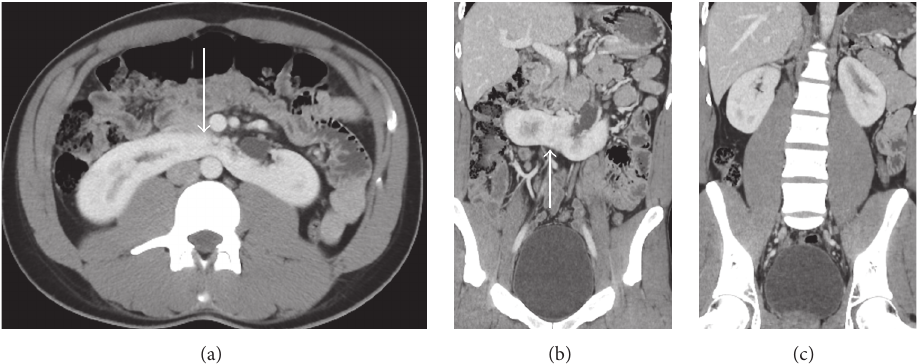
Figure 1: 27-year-old male with horseshoe kidney. Axial (a) and coronal (b) contrast-enhanced CT images show the inferior aspect of a horseshoe kidney in the lower abdomen. Note the enhancing isthmus of renal parenchyma crossing the midline (arrow). A coronal contrast- enhanced CT image (c) obtained more posteriorly shows the upper poles of the horseshoe kidney in the renal fossae.